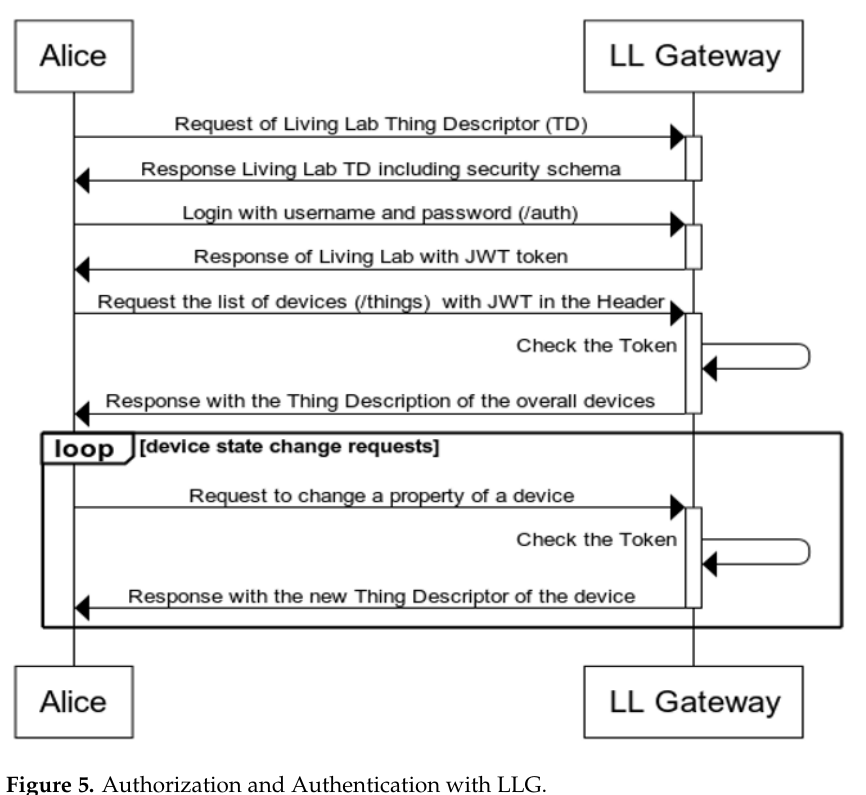
Figure 5. Authorization and Authentication with LLG.